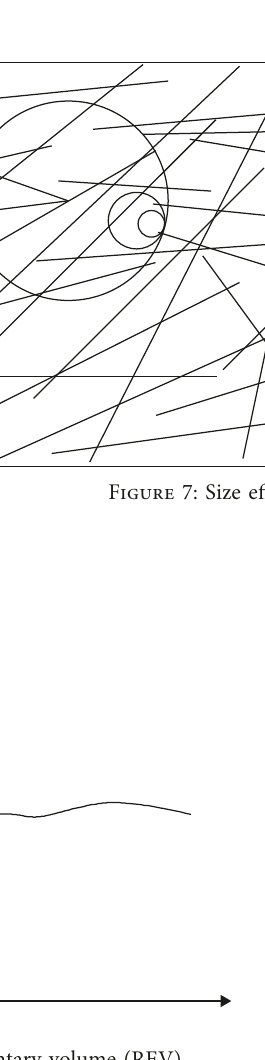
Figure 6: Graph showing numerically simulated values of (a) cohesive strength and (b) internal friction angle of rockmass with different dip angles.